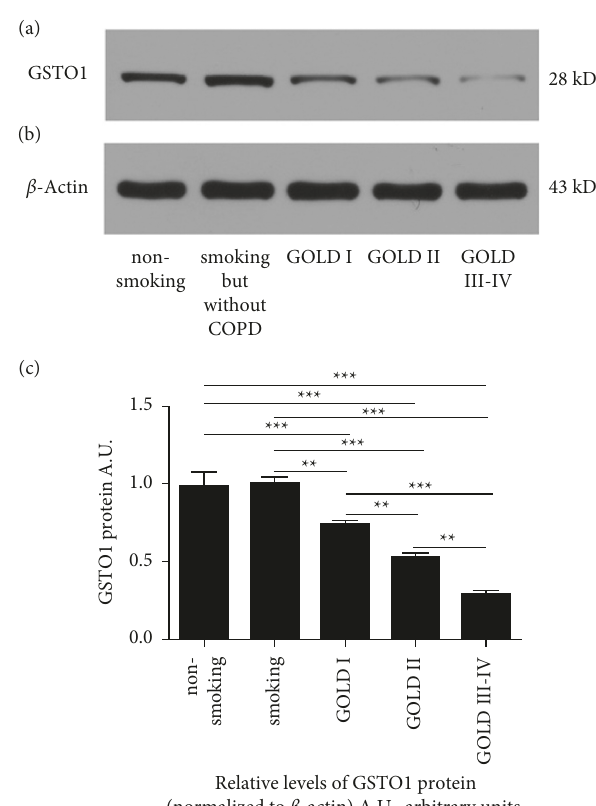
Figure 2: The expression of GSTO1 in blood from different groups of subjects. Representative bands of protein expression for GSTO1 (a) and β -actin (b). (c) Comparison of relative GSTO1 protein levels (normalized to β -actin level) among the different groups. ∗∗ P < 0 . 01, ∗∗∗ P < 0 .